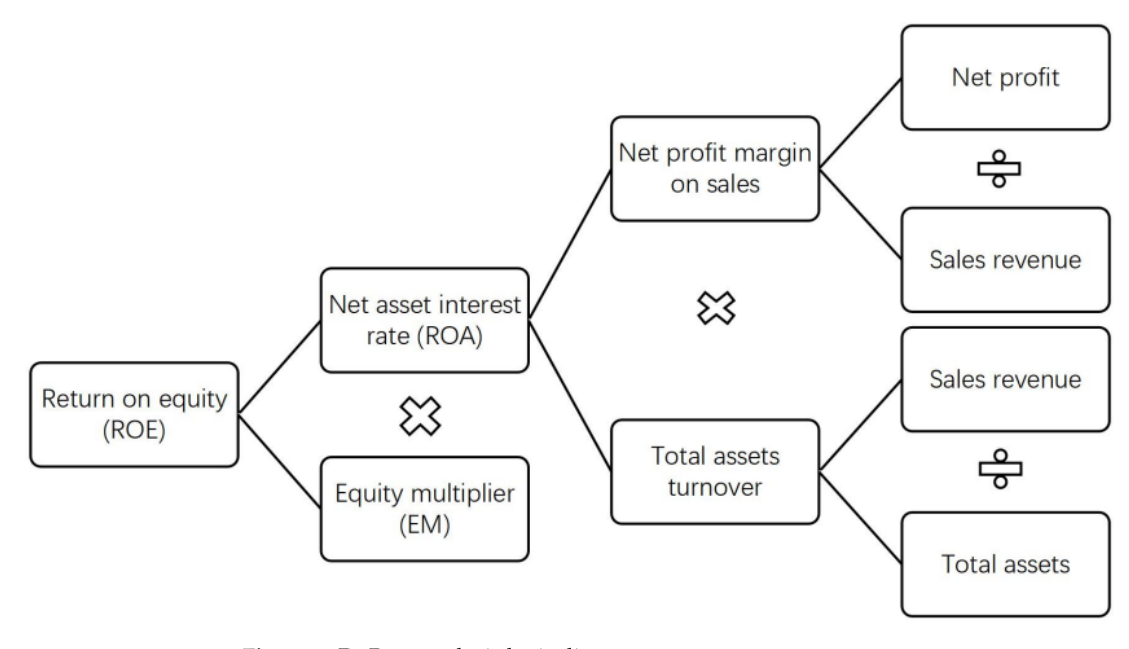
Figure 1. DuPont analysis logic diagram.